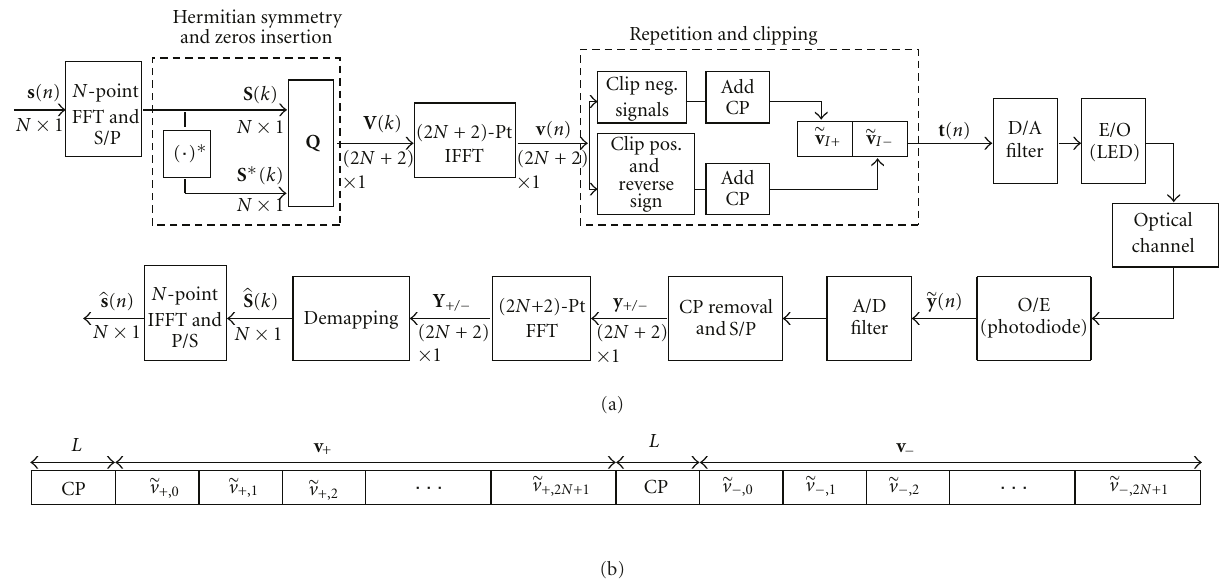
Figure 4: (a) RCO-SCFDE transmitter and receiver configuration. (b) RCO-SCFDE symbol after cyclic extension.